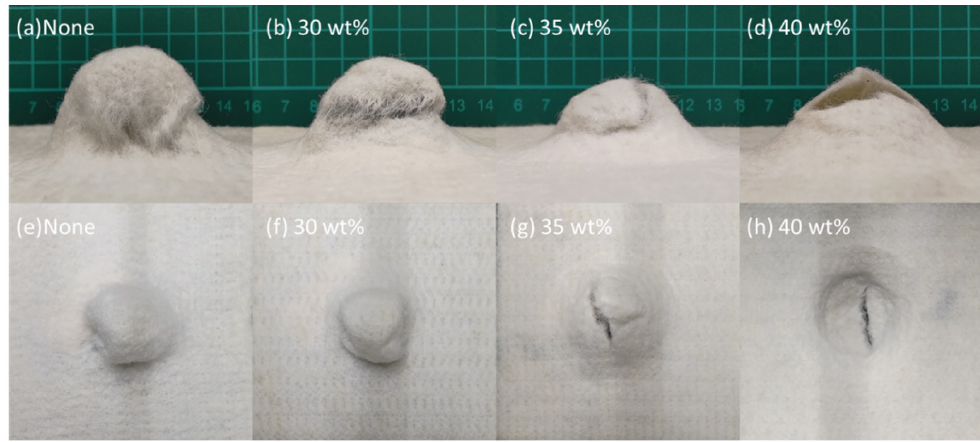
Figure 9. Images of samples after the bursting strength test: ( a–d ) the lateral view; ( e–h ) the top view.